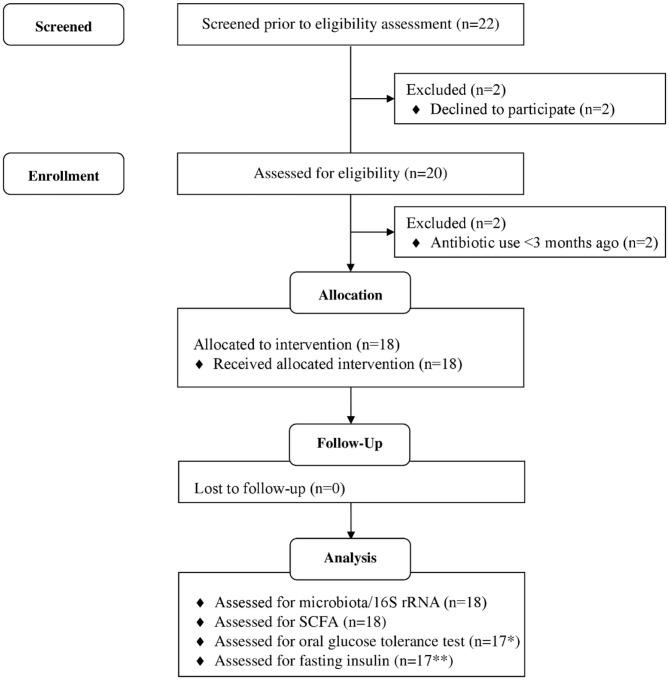
Flow diagram of study participants. *1 participant excluded, as blood samples could not collected due to fainting. **6 participants data excluded as values below threshold of detection of kit. Adapted from (32).